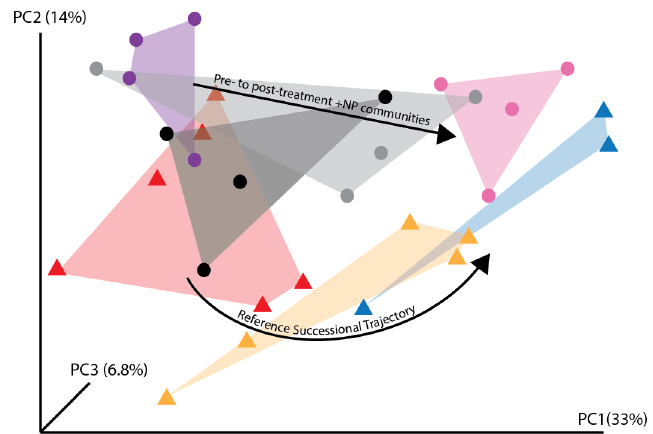
Figure 1. Principal Coordinates Analysis (PCoA) ordination plot of bacterial communities from the field fertilization experiment and bacterial communities from the successional chronosequence. Only the + NP treatment communities are shown because the + N and + P treatments did not result in significant community shifts. PCoA visually represents differences among community composition as the distance between points. Triangles represent communities from the natural chronosequence: red =5 years old; orange =20 years old; blue =85 years old. Circles represent communities from the fertilization experiment: black = pre-treatment control; grey = post-treatment control; purple = pretreatment + NP; Pink = post-treatment + NP. Our analysis revealed significant community shifts over the reference chronosequence (triangles) as well as a significant response to + NP fertilization (circles). As well, the PCoA analysis demonstrates that the + NP communities (pink circles) group with the oldest soils from the chronosequence (blue triangles).